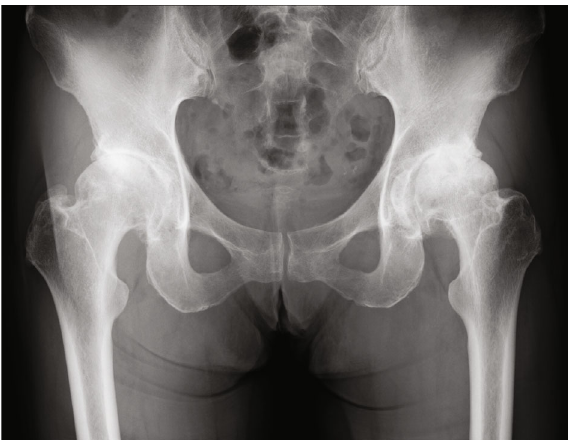
Figure 1: The plain radiograph of initial visit to our hospital at 7 years before surgery. Osteoarthritic changes in both hips without acetabular dysplasia were identi fi